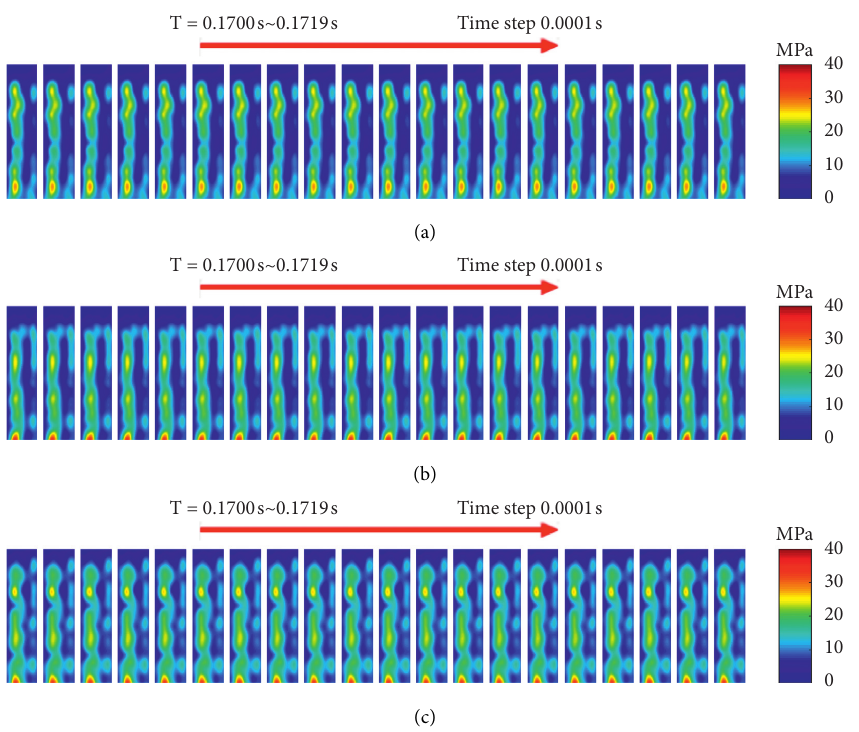
Figure 24: Phase II: Real-time stress distribution of the contact area on axle spline surface under identical loading case, at φ � 0.01 ° , 0.02 ° and 0.04 ° . (a) Real-time stress status with circumferential misalignment φ � 0.01 ° under 0.5m/s2 driving rate, #10 tooth. (b) Real-time stress status with circumferential misalignment φ � 0.02 ° under 0.5m/s2 driving rate, #10 tooth. (c) Real-time stress status with circumferential misalignment φ � 0.04 ° under 0.5m/s2 driving rate, #10